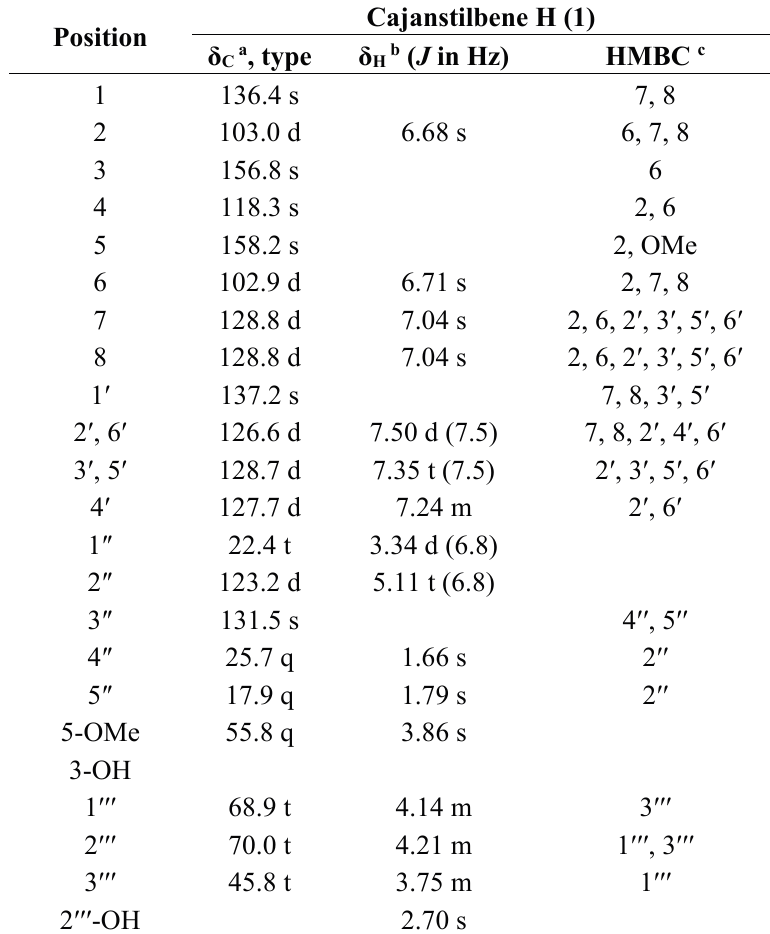
Figure 1. Structure ( A ) and Key HMBC correlations ( B ) of cajanstilbene H ( 1 ). Table 1. 1 H- and 13 C-NMR data of 1 in CDCl 3